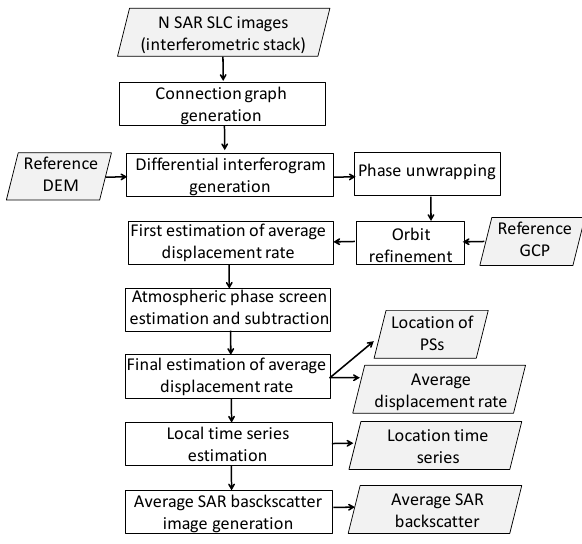
Figure 3. Flowchart of the processing done in this study